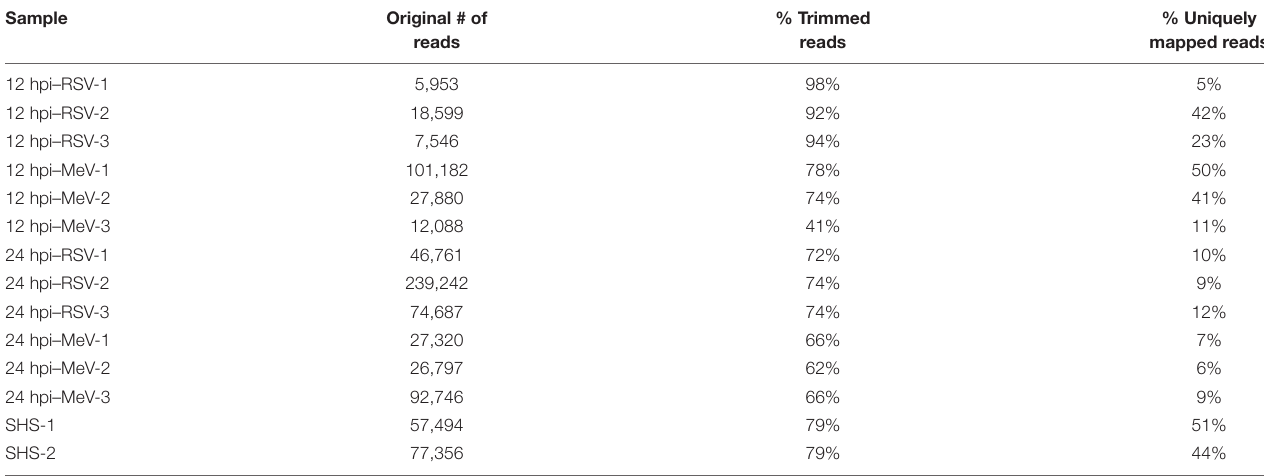
TABLE 1 | Summary of read numbers.